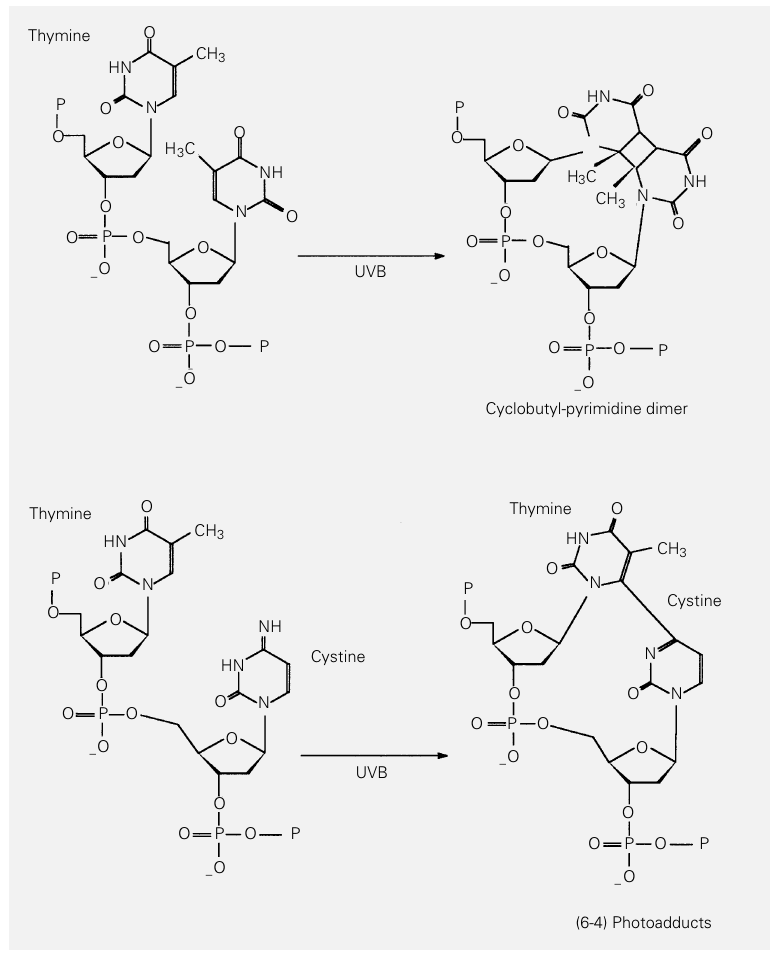
Figure 3 - Photosensitized dimerization of nucleic acids.